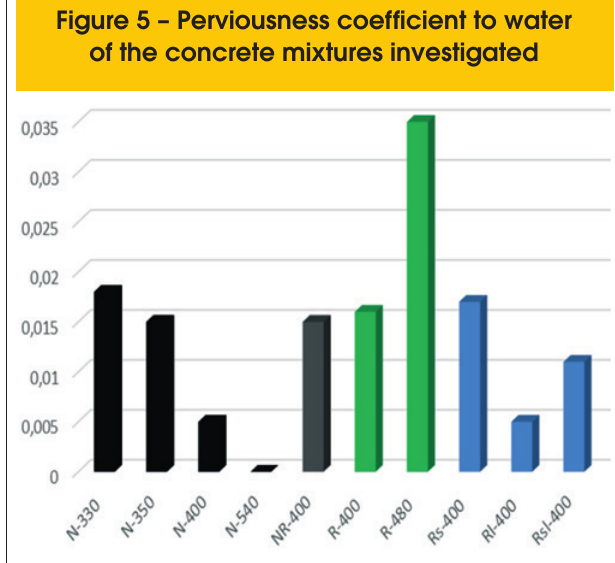
Figure 5 – Perviousness coefficient to water of the concrete mixtures